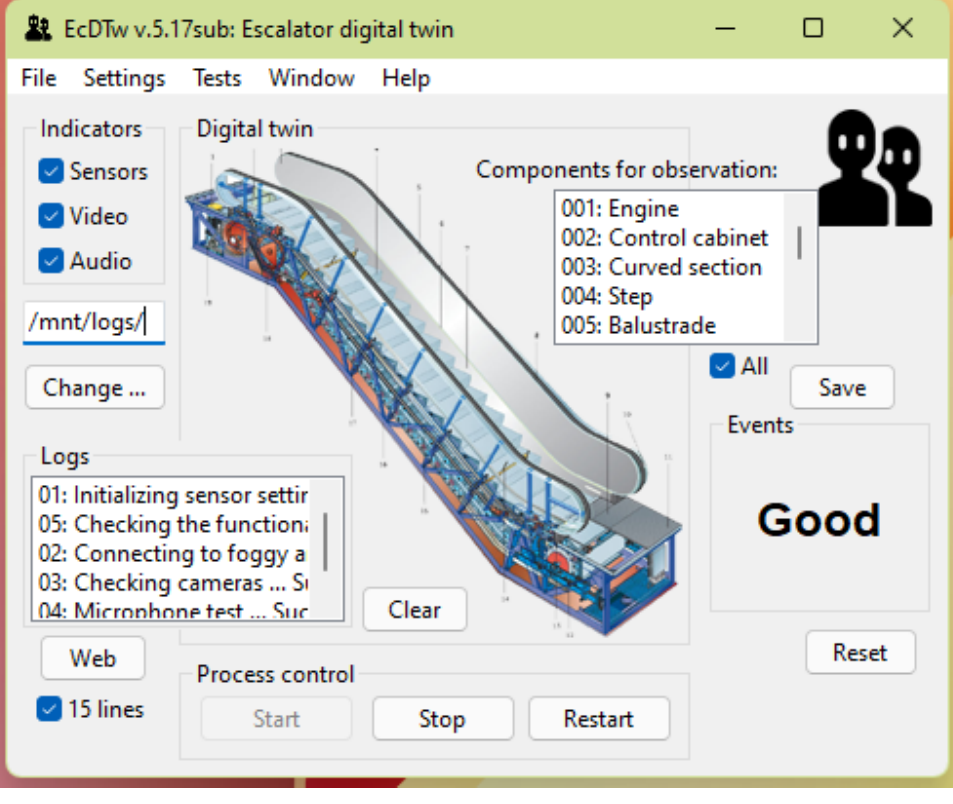
Figure 5. Escalator